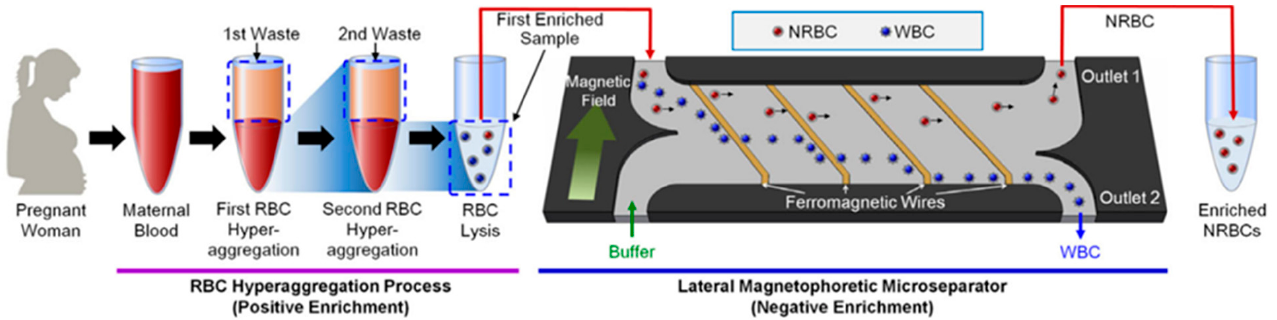
Figure 3. Magnetophoretic platform for prenatal diagnostic testing. Nucleated red blood cells in the maternal blood sample were isolated using a magnetophoretic microseparator for further testing. Reproduced with permission [59]. Copyright 2015 Springer